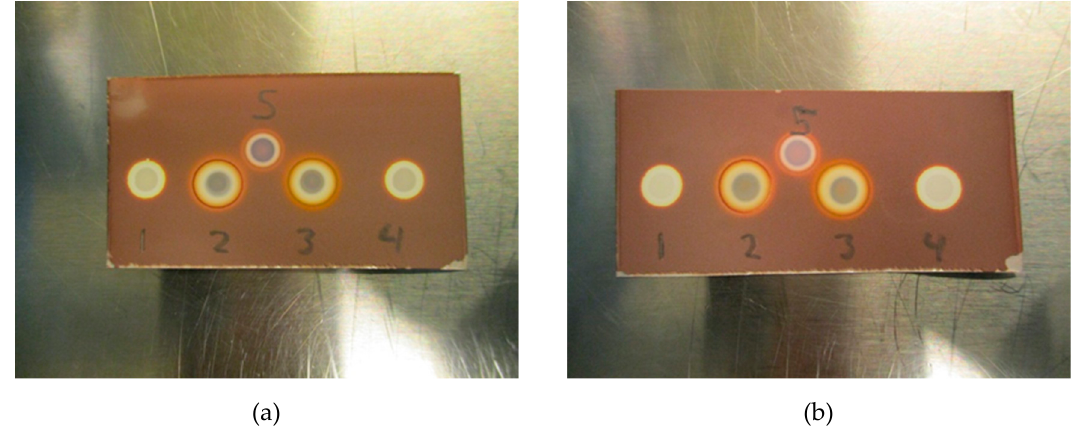
Figure 7. ( a ) Test with Kryptofix. (1) Kryptofix (0.22 mg/mL in 20 mg/mL ascorbate matrix), (2) Kryptofix (0.22 mg/mL in 20 mg/mL ascorbate matrix) + H 2 O 2 , (3) Kryptofix (0.22 mg/mL in 5 mg/mL ascorbate matrix) + H 2 O 2 , (4) Kryptofix (0.22 mg/mL in 5 mg/mL ascorbate matrix), (5) Kryptofix (0.22 mg/mL in matrix without ascorbate). ( b ) Test with Kryptofix at lower concentration. (1) Kryptofix (0.11 mg/mL in 20 mg/mL ascorbate matrix), (2) Kryptofix (0.11 mg/mL in 20 mg/mL ascorbate matrix) + H 2 O 2 , (3) Kryptofix (0.11 mg/mL in 5 mg/mL ascorbate matrix) + H 2 O 2 , (4) Kryptofix (0.11 mg/mL in 5 mg/mL ascorbate matrix), (5) Kryptofix (0.11 mg/mL in matrix without ascorbate).